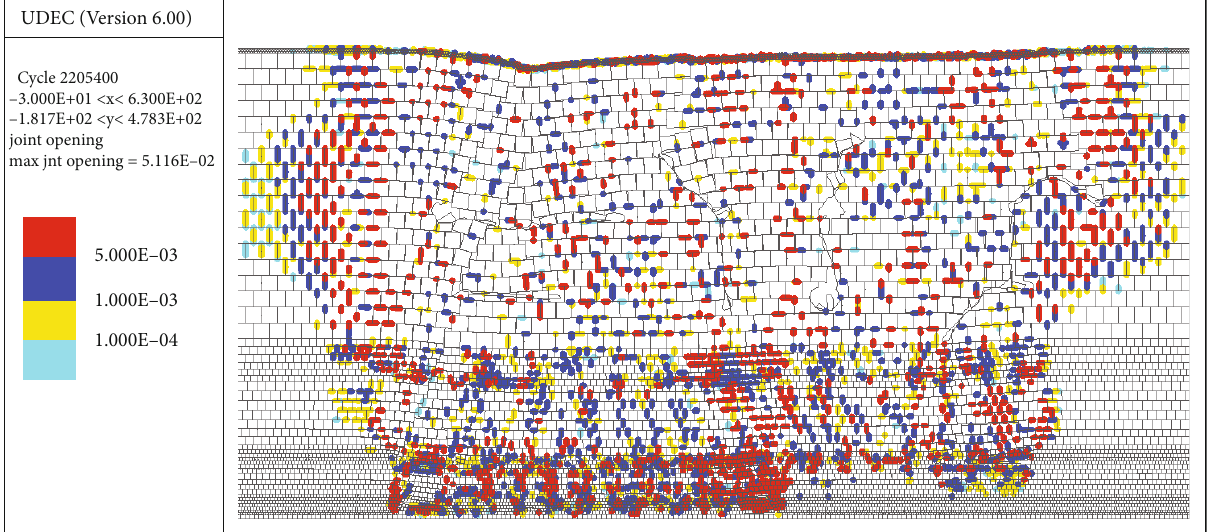
Figure 9: Mining-induced fracture fi eld (mining distance is 340 m in 9# coal seam).